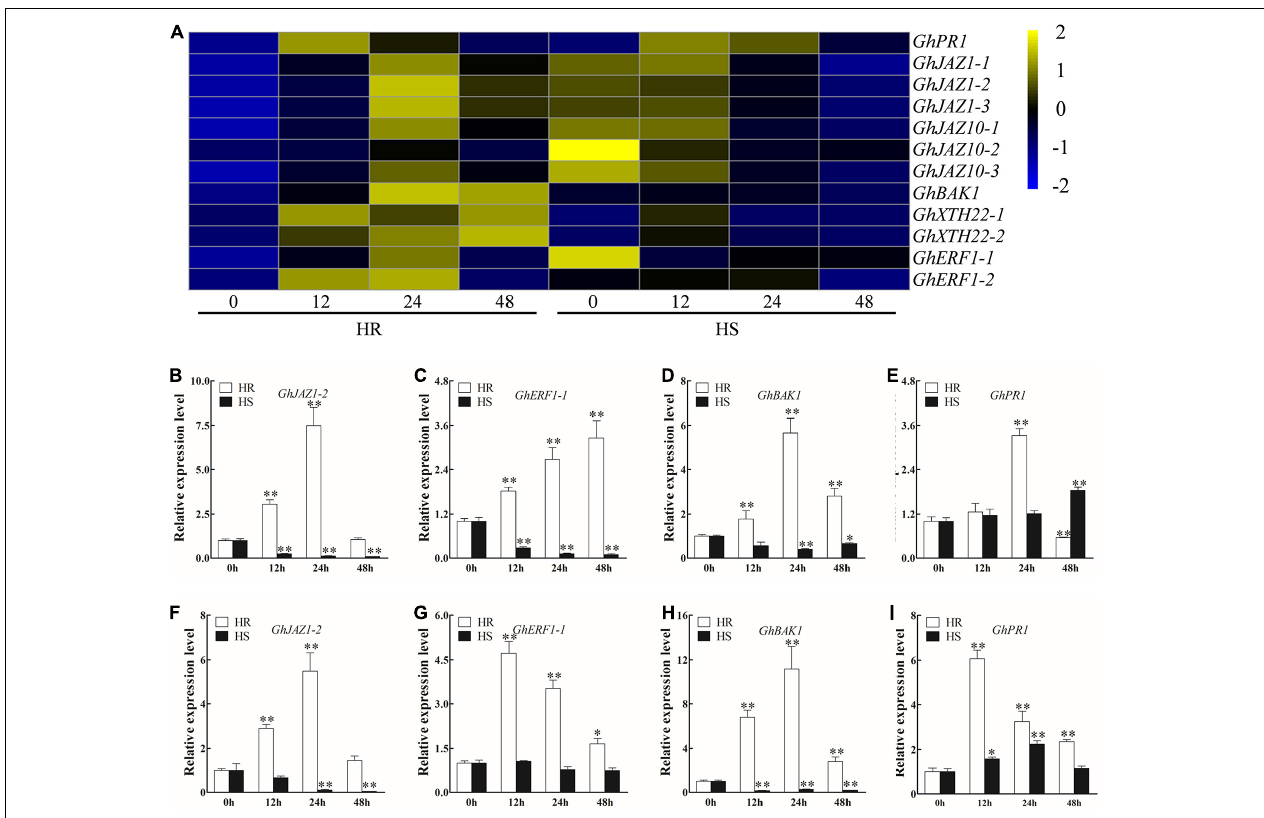
FIGURE 3 | Transcriptional profile of plant hormone signal transduction-related genes after Verticillium dahliae infection. (A) Heatmap showing the expression pattern of plant hormone signal transduction-related genes in Shidalukang 1 (HR) and Junmian 1 (HS) at 0, 12, 24, and 48 h post-inoculation (hpi). The heatmap was generated using fragments per kilobase of transcript sequence per million base pairs sequenced values normalized by Z-score. (B–E) Relative expression levels of plant hormone signal transduction-related genes (B) GhJAZ1-2 , (C) GhERF1-1 , (D) GhBAK1 , and (E) GhPR1 in the roots of HR and HS at 0, 12, 24, and 48 hpi. (F–I) Relative expression levels of plant hormone signal transduction–related genes (F) GhJAZ1-2 , (G) GhERF1-1 , (H) GhBAK1 , and (I) GhPR1 in the stems of HR and HS at 0, 12, 24, and 48 hpi. Values represent mean ± SE of three independent biological replications (five individual plants per replicate). For each cultivar, the expression level at each time point was compared with that at 0 hpi that was set to 1. ∗ and ∗∗ represent significant differences from roots of the same cultivar at P < 0.05 and P < 0.01, respectively, based on Student’s t